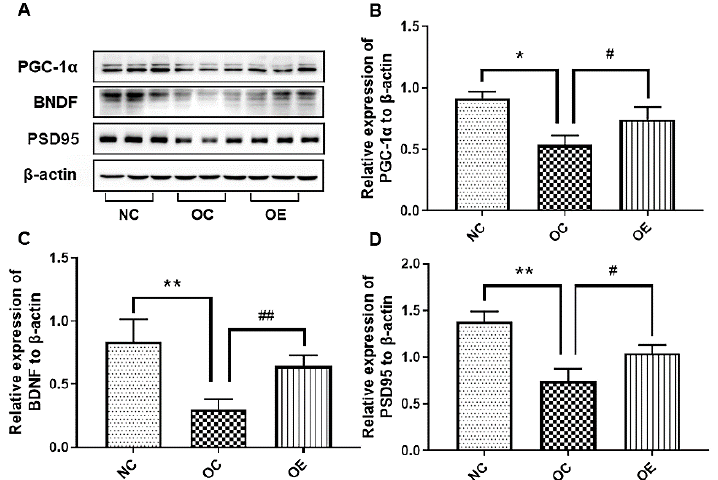
Figure 6. The Western blot of proteins associated with neurotrophic factors and synaptic plasticity ( A ) and corresponding statistical analysis of PGC- 1α ( B ), BDNF ( C ), and PSD95 ( D ) expression levels in hippocampal tissues of the mice. All data were presented as mean ± standard deviation (M ± SD) ( n = 3 mice per group). Compared with the NC group, * p < 0.05, ** p < 0.01; compared with the OE group, # p < 0.05, ## p < 0.01.